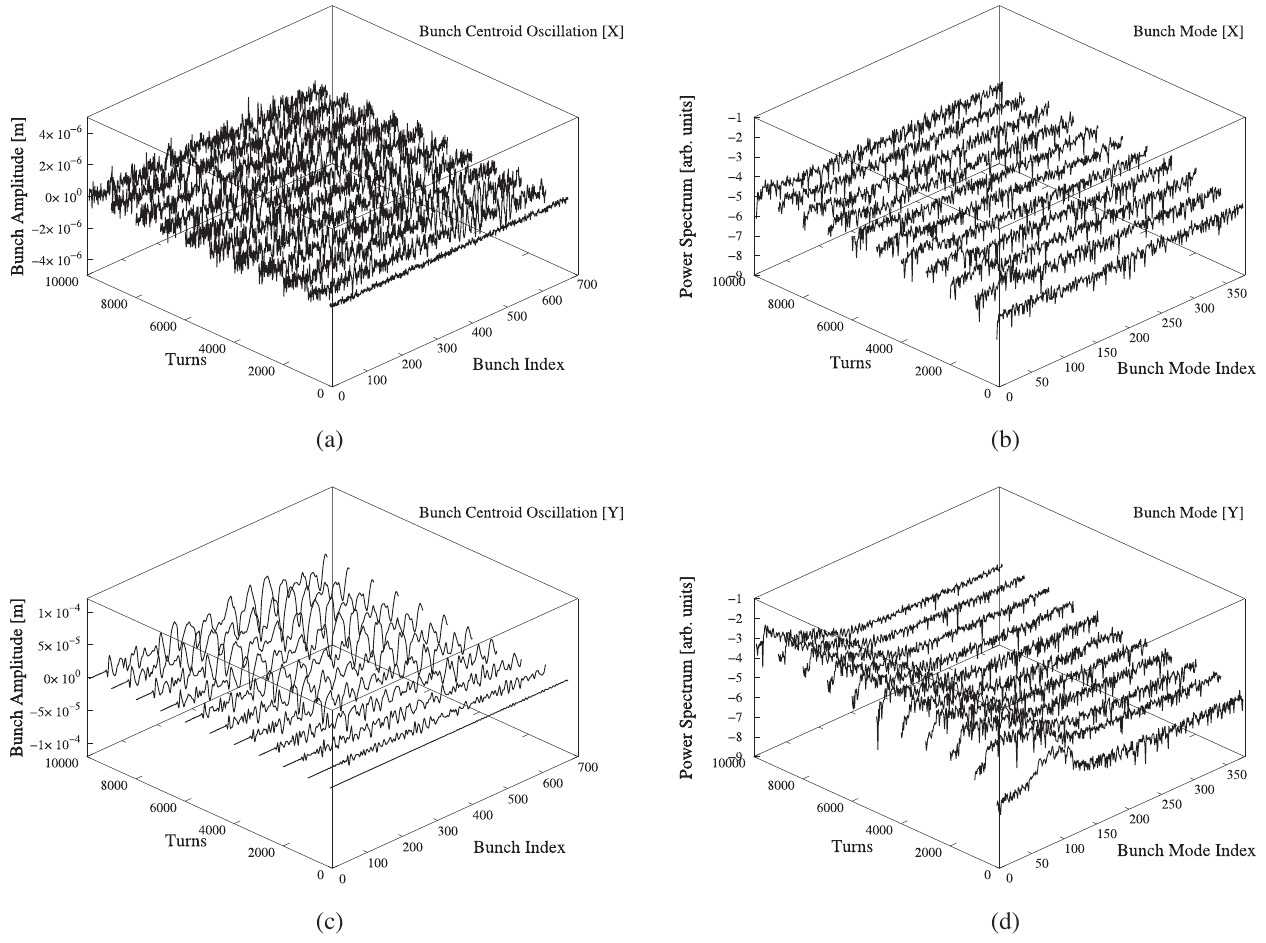
FIG. 6. Beam bunch oscillations in the horizontal (top) and vertical (bottom) and their frequency spectrum as a function of the passing turns. The simulation results are given by the “ strong-strong ” model with synchrotron radiation damping and quantum